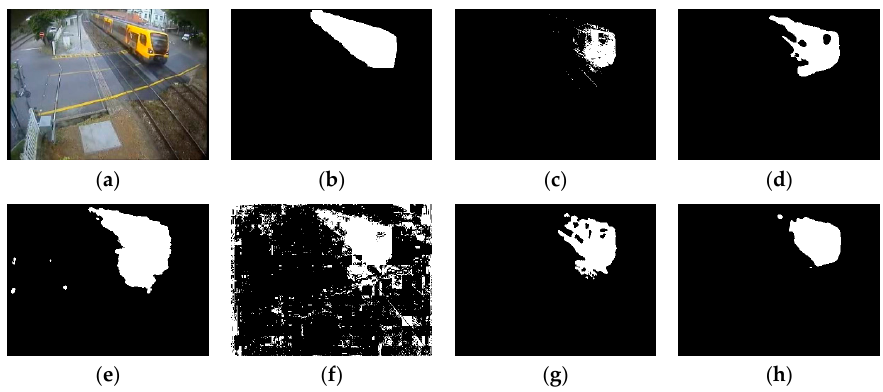
Figure 7. ( a ) is the frame 389 of input images; ( b ) ground truth; ( c ) GMM (Gaussian Mixture Modeling); ( d ) ViBe (Visual Background extractor); ( e ) GMG (an algorithm for finding the Global Minimum with a Guarantee); ( f ) KDE (Kernel Density Estimation); ( g ) LBAdaptiveSOM (Local Background Adaptive Self-Organizing Modeling); and ( h ) our method.